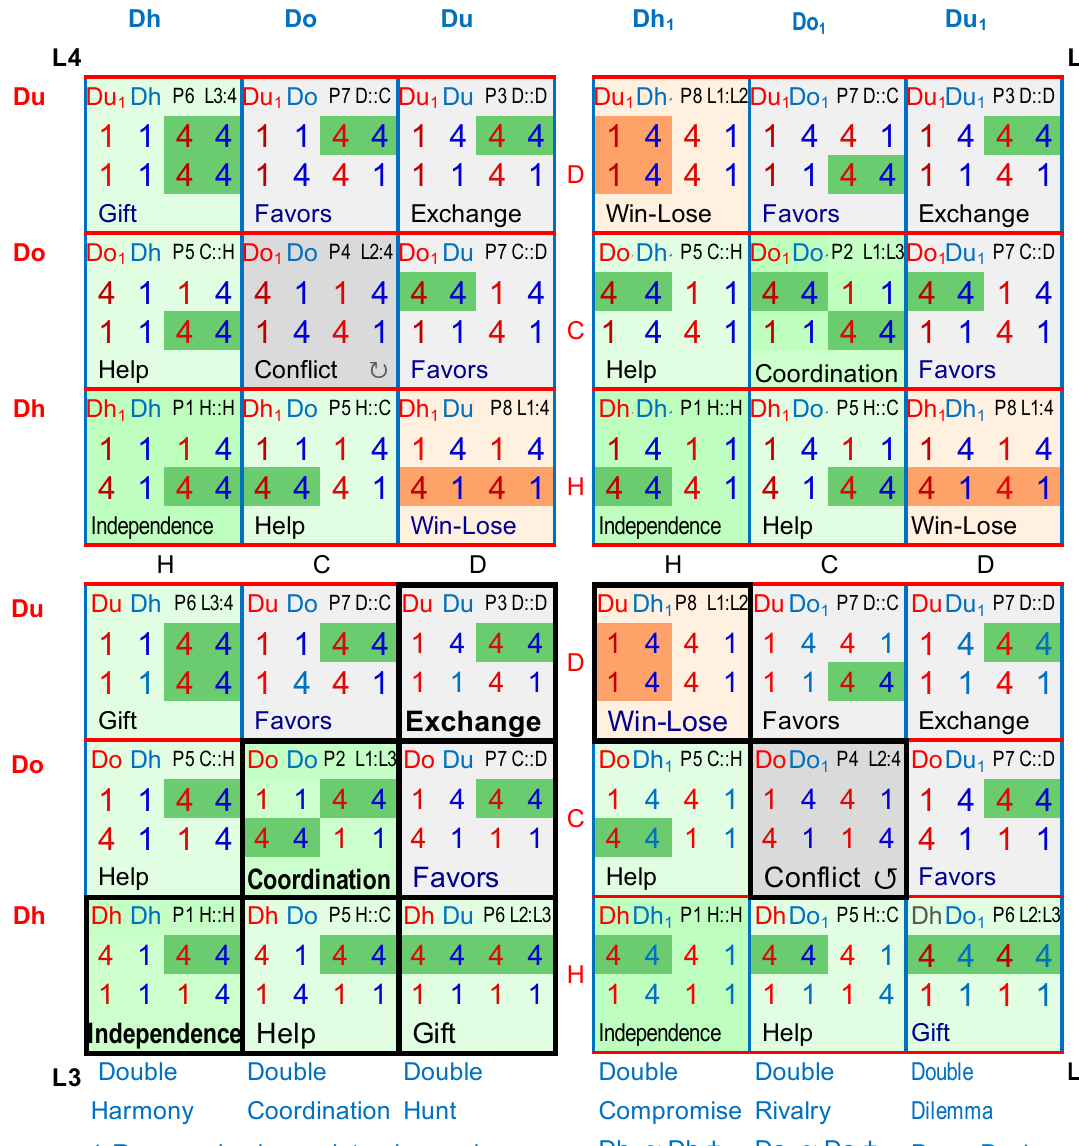
Figure A7. Primal archetypes with variants that interchange rows and columns or positions. These are formed by making ties in the topology of strict 2x2 games for the two highest- ranked and two lowest-ranked outcomes. Each tile of four games in Figure A3 collapses into a single game. Symmetric games still form an axis of symmetry from lower left to upper right. Games on either side of the axis are still equivalent by switching positions as Row or Column. Equivalently-located tiles form hotspots linking two layers or pipes linking four